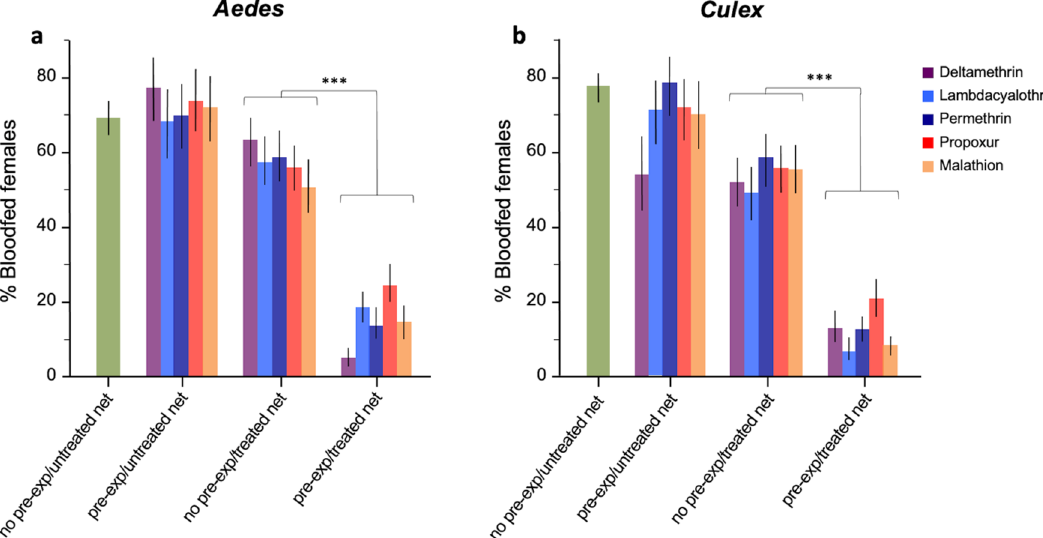
Figure 1. Proportion of blood feeding in ( a ) unconditioned and conditioned Aedes aegypti and ( b ) Culex quinquefasciatus females exposed to untreated and treated bed nets in the WHO tunnels test. Error bars represent 95% confidence intervals. P values are P < 0.001